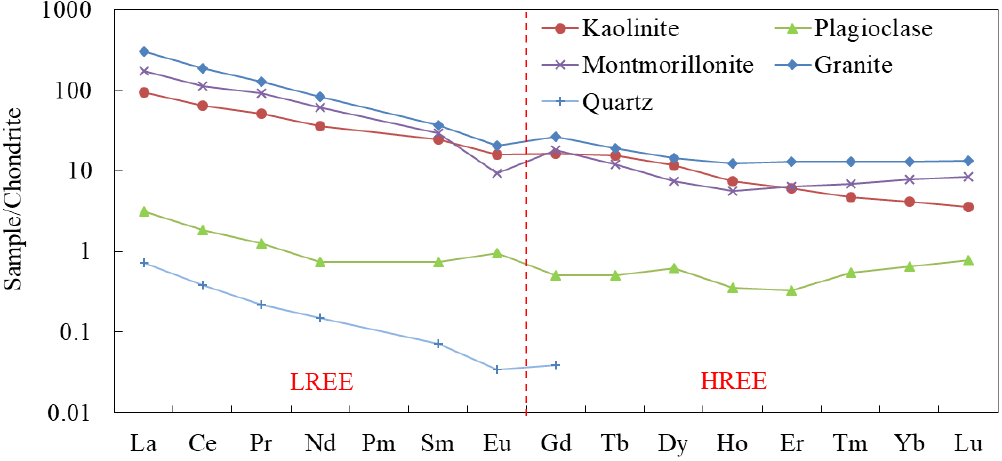
Figure 2. Chondrite - normalized REE patterns in the mineral samples. Figure 2. Chondrite-normalized REE patterns in the mineral